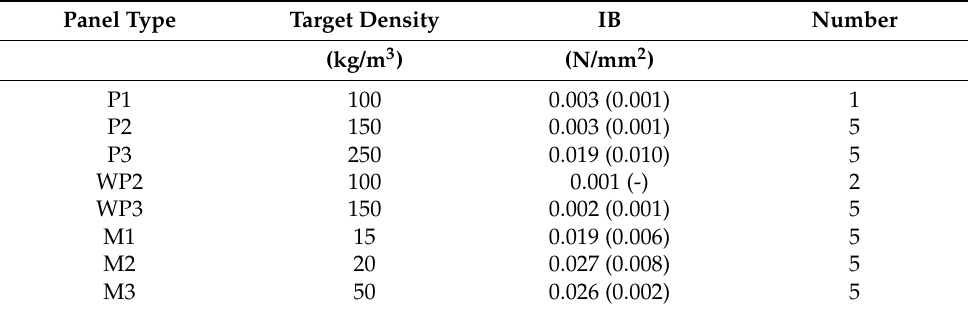
Table 3. Internal bond of moss samples (SD in